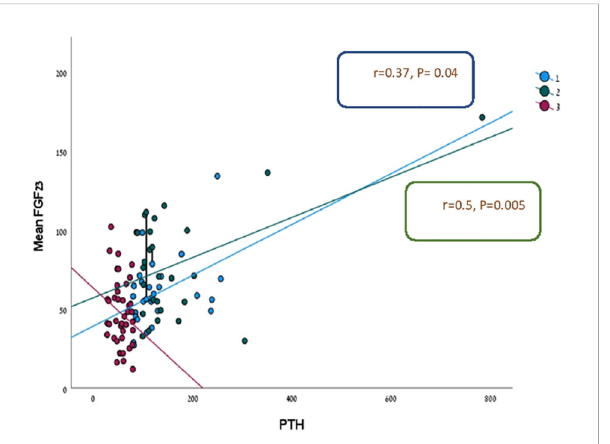
FIGURE 1 Linear regression analysis for prediction FGF-23 level according to PTH in three study groups.